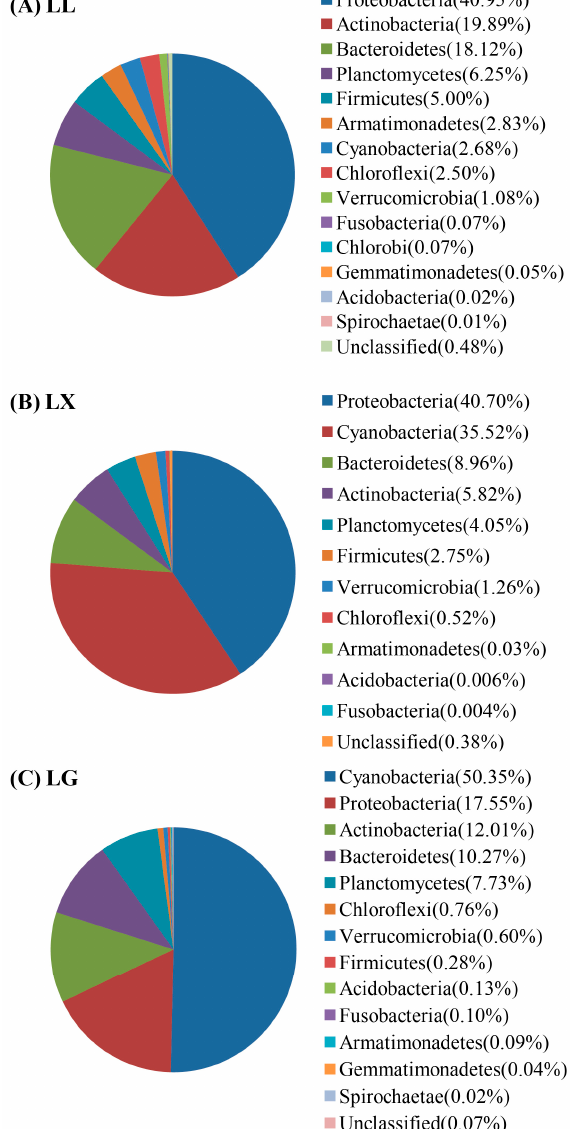
Figure 3. Taxonomic classification of water bacterial community reads of Illumina Miseq sequencing data of ( A ) Lianhu lake (LL), ( B ) Xingqing lake (LX), and ( C ) Geming lake (LG) into phylum levels using the Ribosomal Database Project (RDP) classifier.